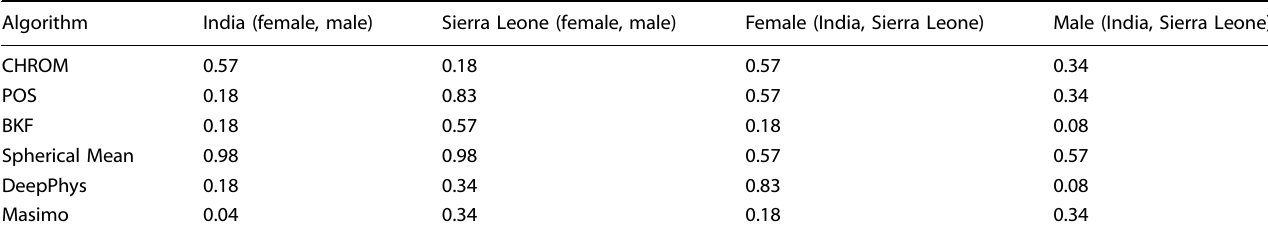
Table 9. Gender analysis within populations for rPPG methods showing p values for hypothesis tests de fi ned in the section “ Tests within populations for rPPG methods with respect to gender ” after the removal of the outlier